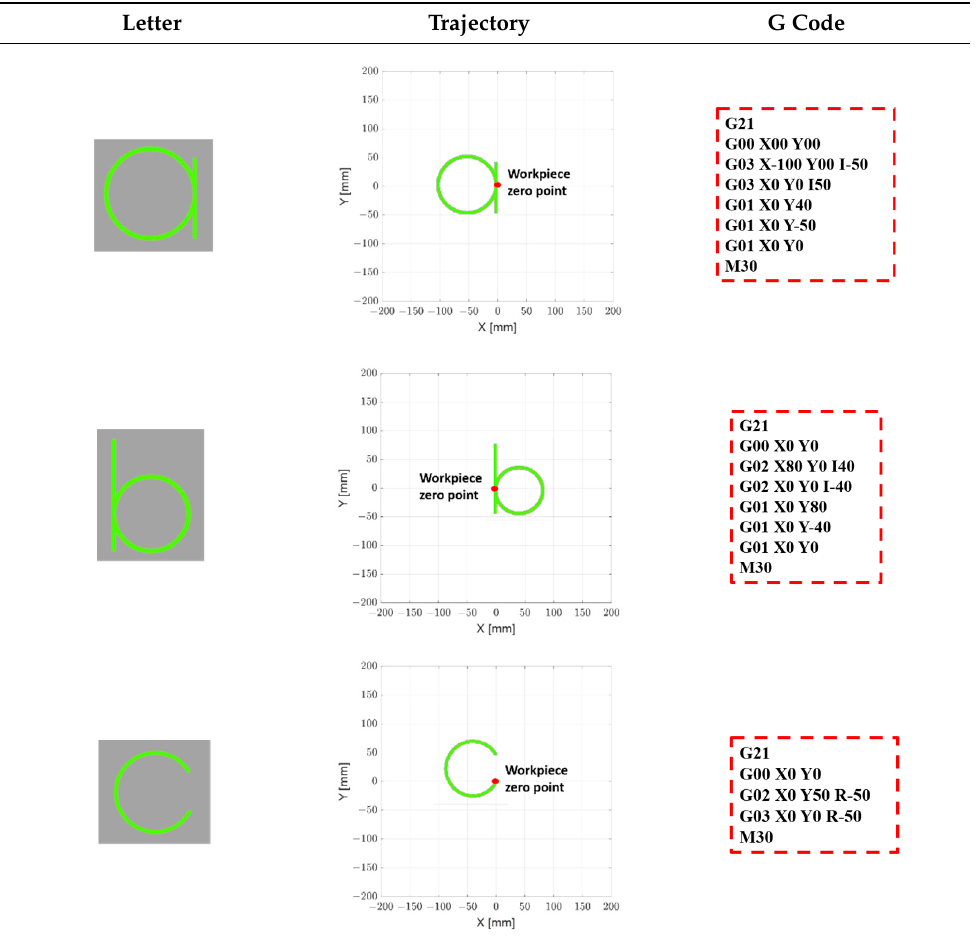
Figure 20. Physical prototype of the ankle rehabilitation machine. Table 7. G code for rehabilitation movements.